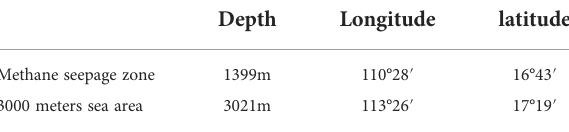
TABLE 1 Basic parameters of the work